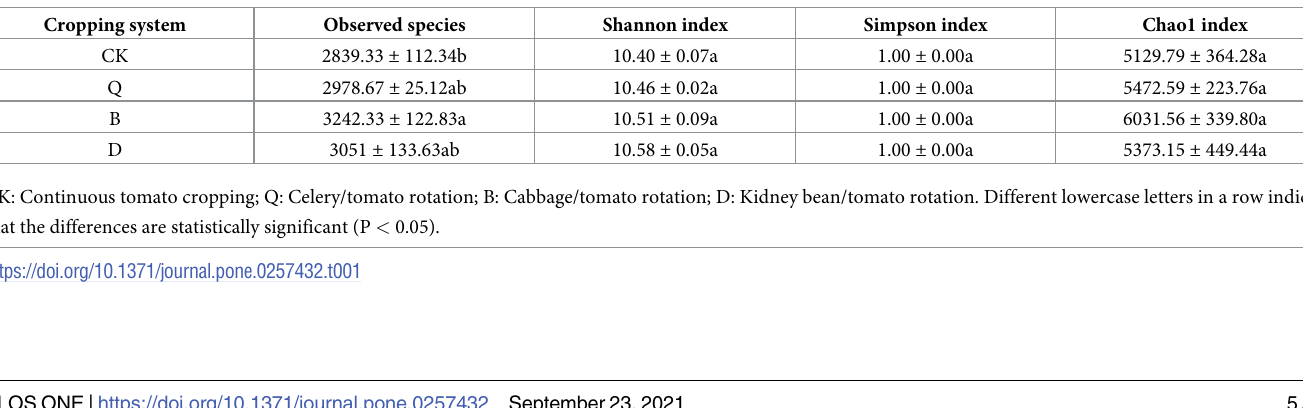
Table 1. Comparison of species numbers and 16S (bacterial) diversity indices observed in the different cropping systems. Cropping system